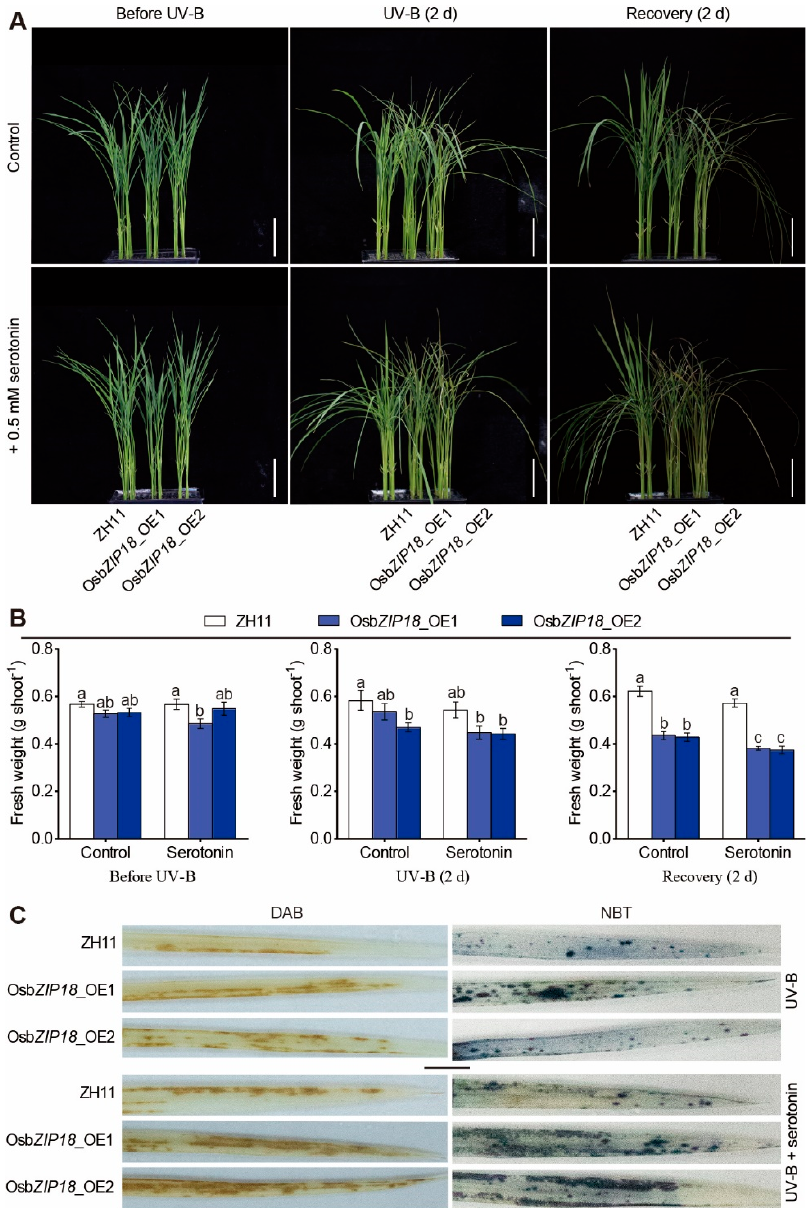
Figure 6. Serotonin increases the UV-B stress-sensitive phenotypes of the OsbZIP18 -overexpression plants. ( A ) Phenotype comparison of the OsbZIP18 -overexpression plants ( OsbZIP18 _OE1 and OsbZIP18 _OE2) before UV-B treatment, after UV-B treatment for 2 d, and after recovery from the UV-B treatment. The plants were grown in a nutrient solution with or without 0.5 mM serotonin. The plants were pretreated with 0.5 mM serotonin for 24 h before UV-B treatment. Scale bars = 5 cm. ( B ) The fresh weight of shoots in ( A ). The data are means ± SD of nine biological replicates. Different letters indicate a significant difference at p < 0.05. ( C ) Accumulation of ROS in the leaves treated with UV-B or UV-B + serotonin for 36 h. Scale bars = 5 mm.